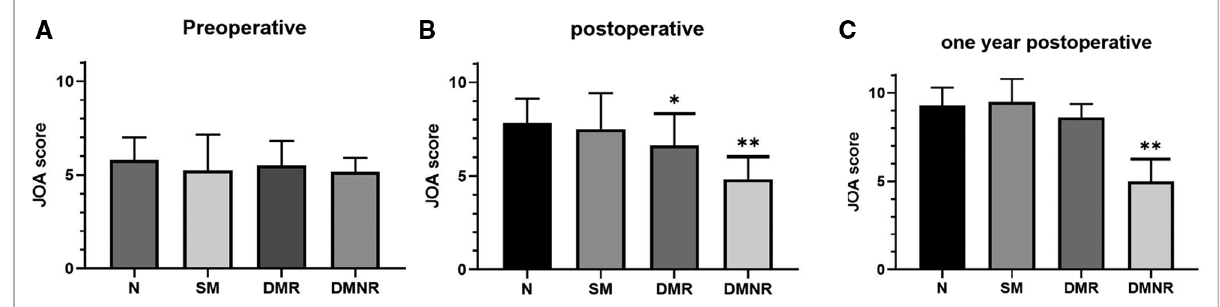
FIGURE 2 JOA score before and after surgery and at last follow-up. ( A ): JOA score of each group before surgery, no signi fi cant difference. * P <0.05 and ** P < 0.01; ( B ): The JOA score of the postoperative DMR group ( P <0.05) and DMNR group ( P <0.01) was lower than that of the normal group. ( C ): Compared with the N group, the JOA score decreased in the DMNR group one year after surgery ( P <0.01). JOA, Japanese Orthopaedic